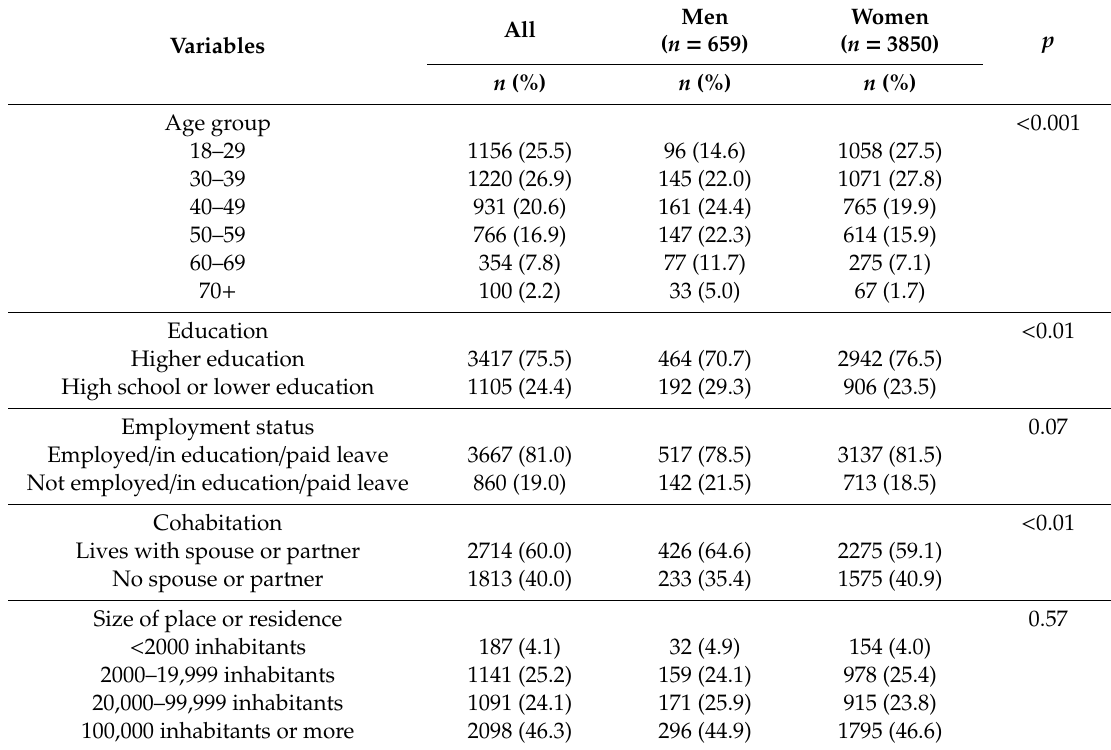
Table 1. Sample characteristics ( n =